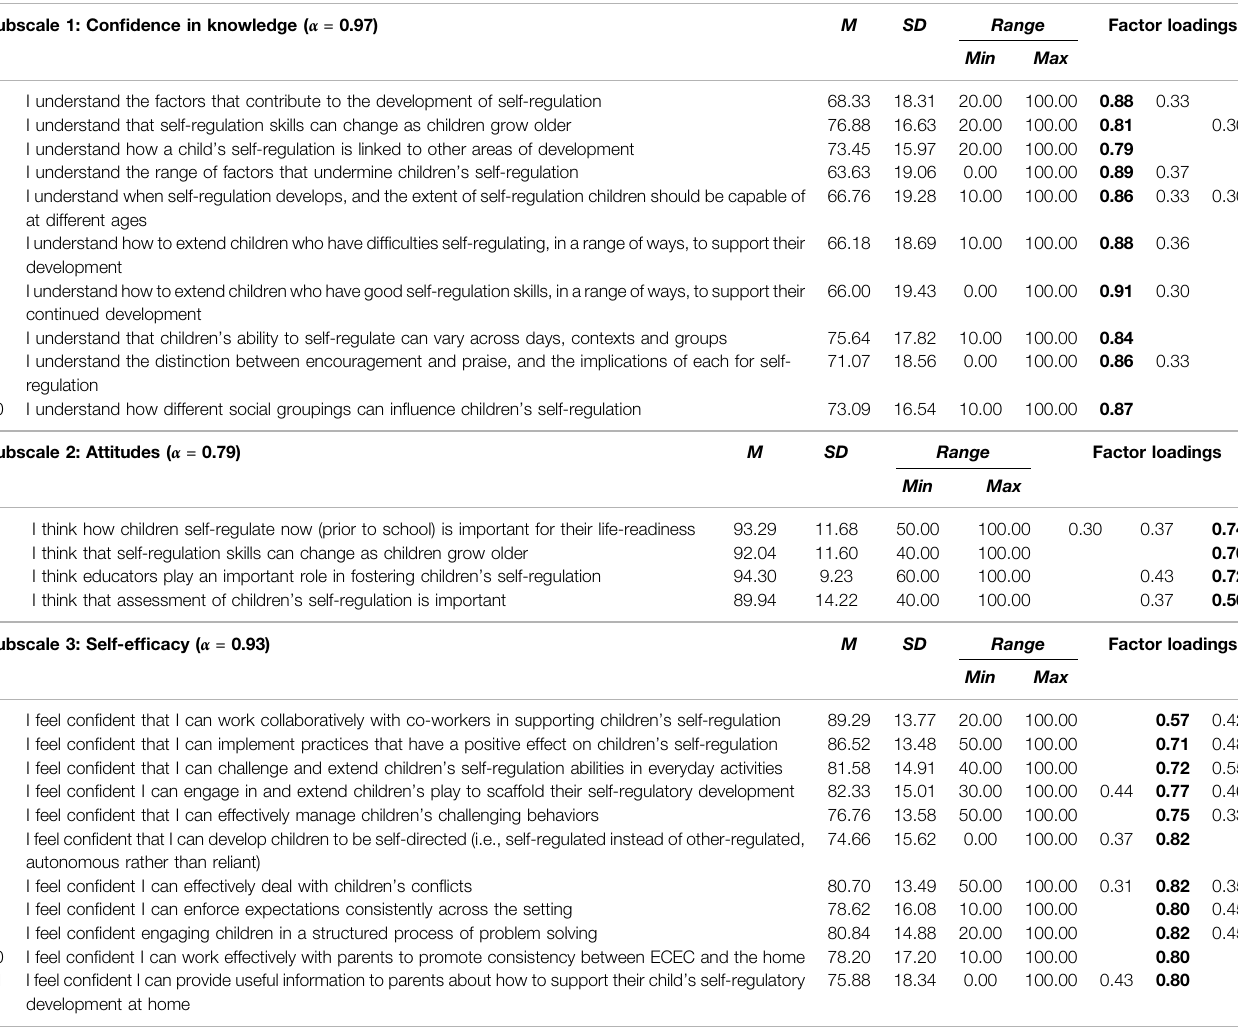
TABLE 1 | Descriptive statistics for Self-Regulation KASE items by subscale and EFA factor loadings. Subscale 1: Con fi dence in knowledge ( α = 0.97)